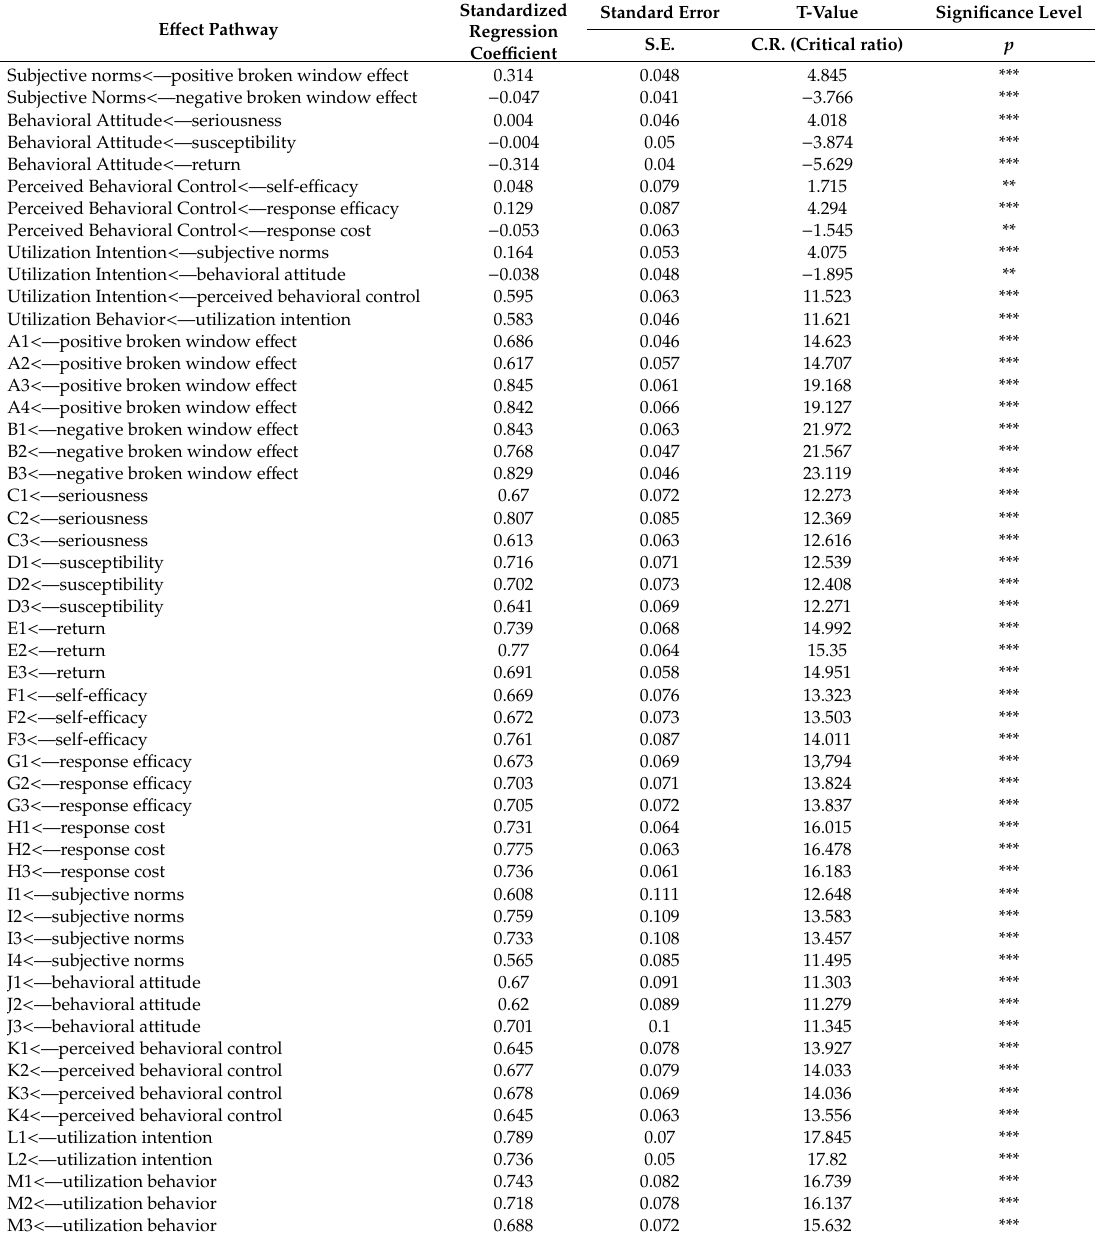
Table 2. Estimated Results of Model Path Coe ffi